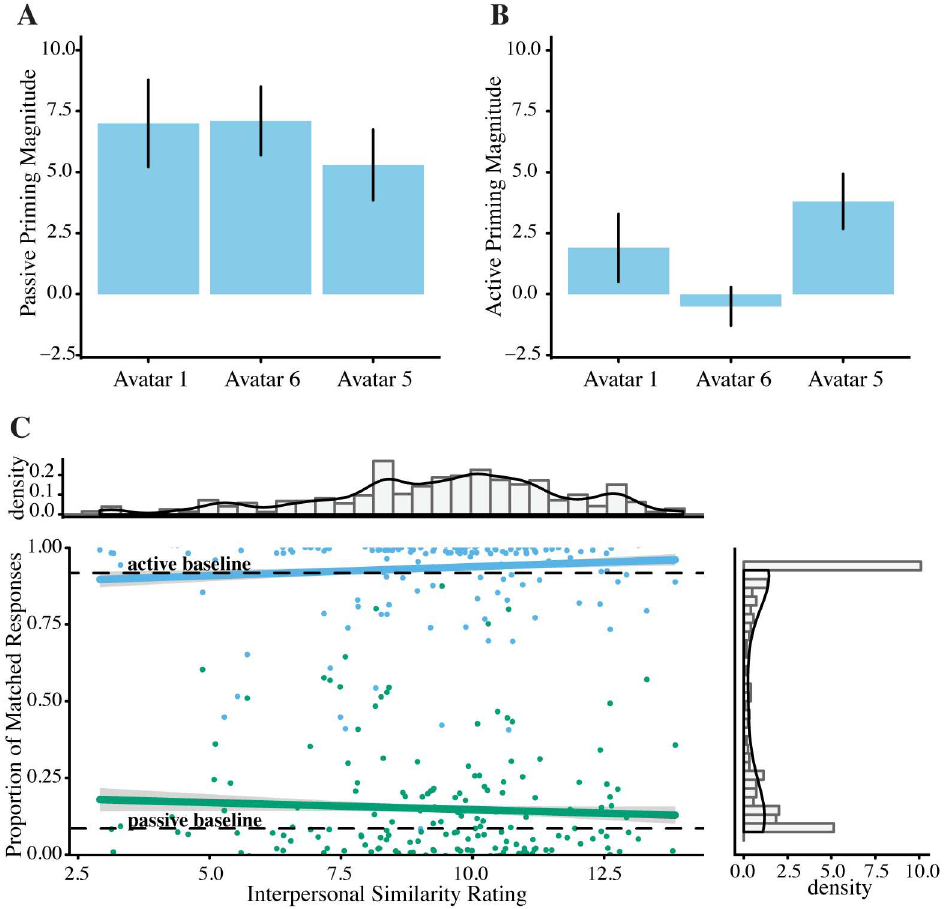
Fig 4. Influences on Priming Magnitude. A. Passive primingmagnitudeper avatar; althoughthere is a significantpriming effect, there was no significantdifference betweenpartner types ( p > .05) B. Active priming magnitude per avatar; although there is a significantpriming effect, there was no significantdifference betweenpartner types ( p < .05). Error bars representstandard error. C. There was no significanteffect of Interpersonal Similarity rating on primingmagnitudefor either structure. Error clouds represent standard error.